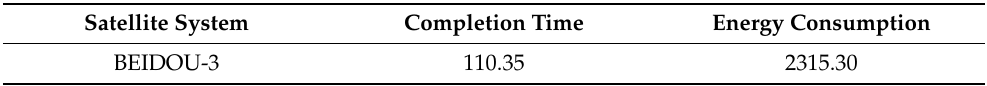
Table 3. The simulation results, completion time and energy consumption of the BEIDOU-3 satel- lite.